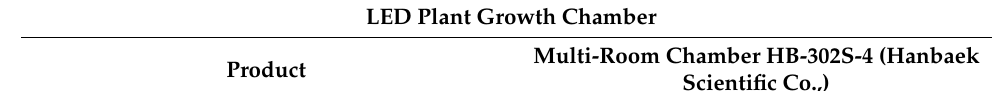
Table A1. Plant growth method using LED lights.